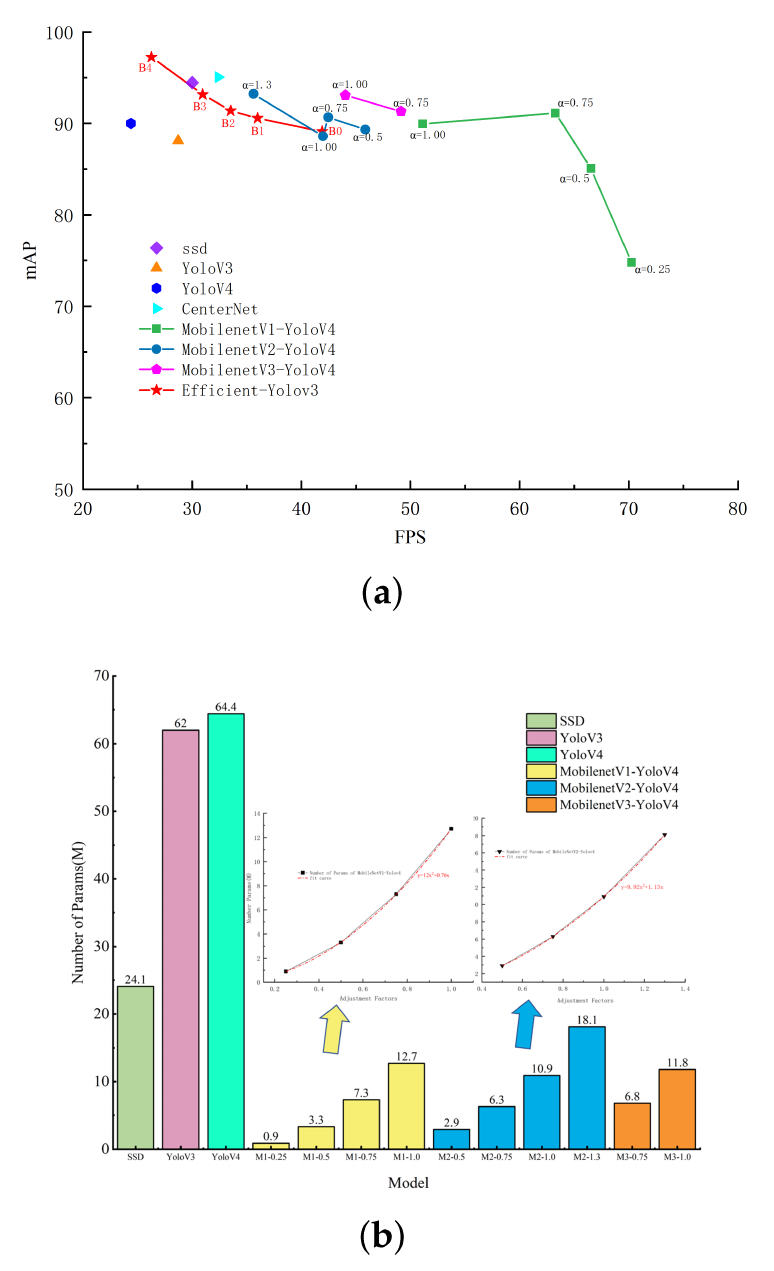
Figure 7. The effect of adjusting the model scaling factor on the test results: ( a ) the performance comparison between different models, ( b ) comparison of model